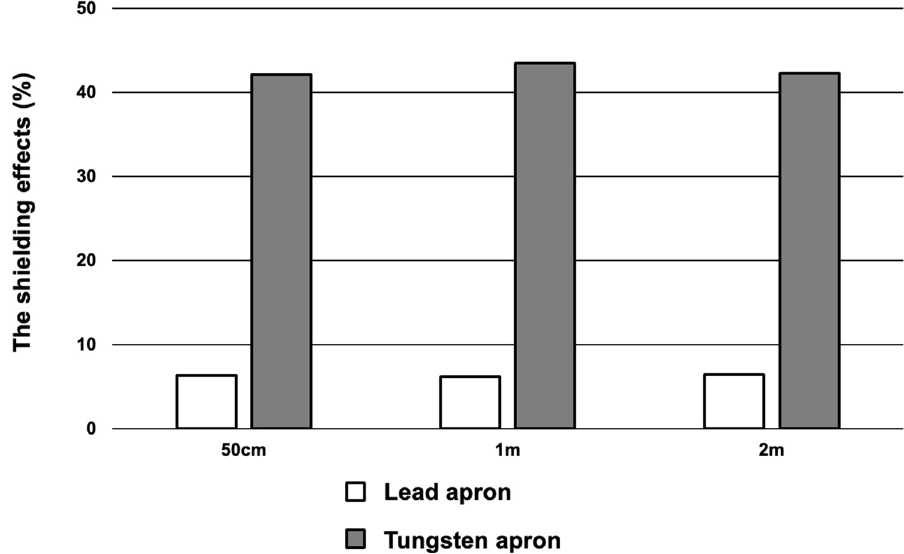
Figure 2. The shielding effects of lead and tungsten aprons against 131 I. The tungsten apron of 2 mmPb equivalent and the lead apron of 0.35 mmPb equivalent were set at 50 cm, 1 m and 2 m from the radioactive source. The tungsten apron had a significantly higher shielding effect 131 I at all distances than the lead apron.